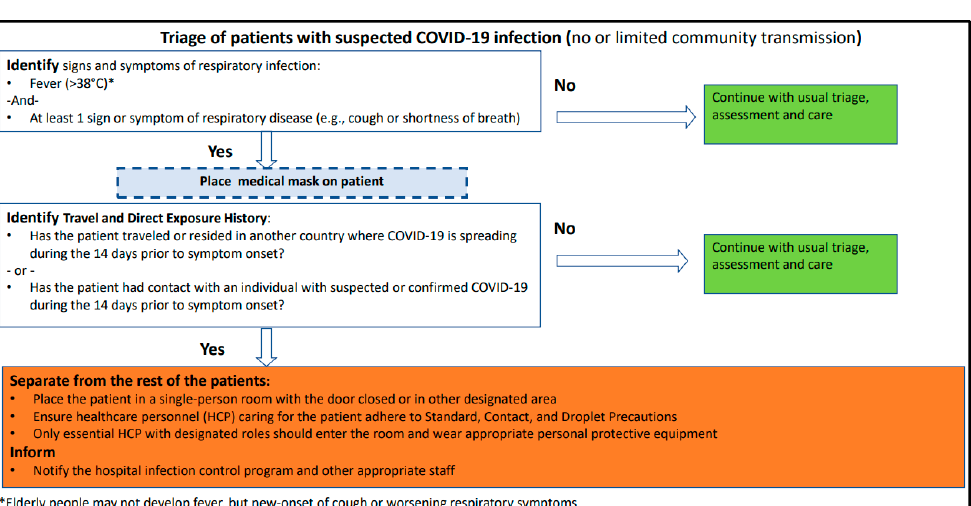
Figure 6. Triage Protocol by CDC [60].